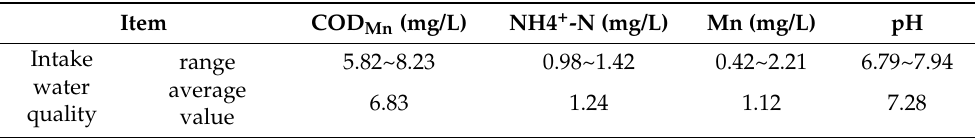
Table 1. A schematic diagram of aeration biofilters #1 and